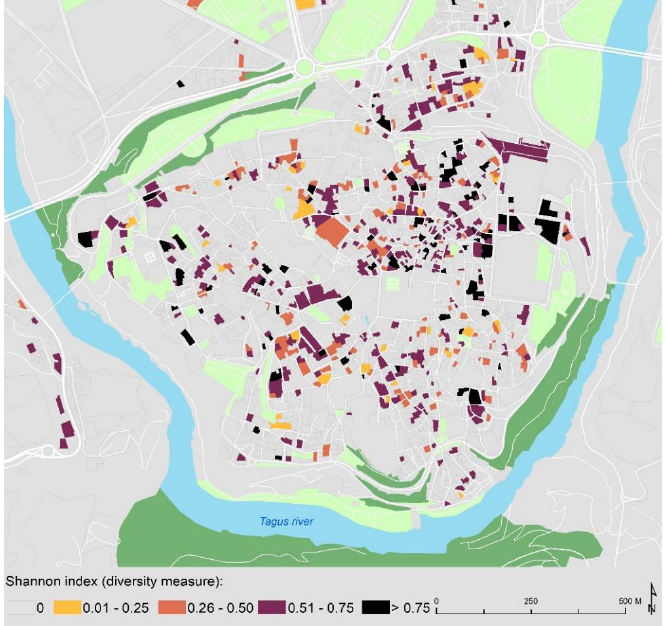
Figure 7. Shannon index (diversity) of the land uses in the historic centre of Toledo. Source: Authors’ own elaboration.